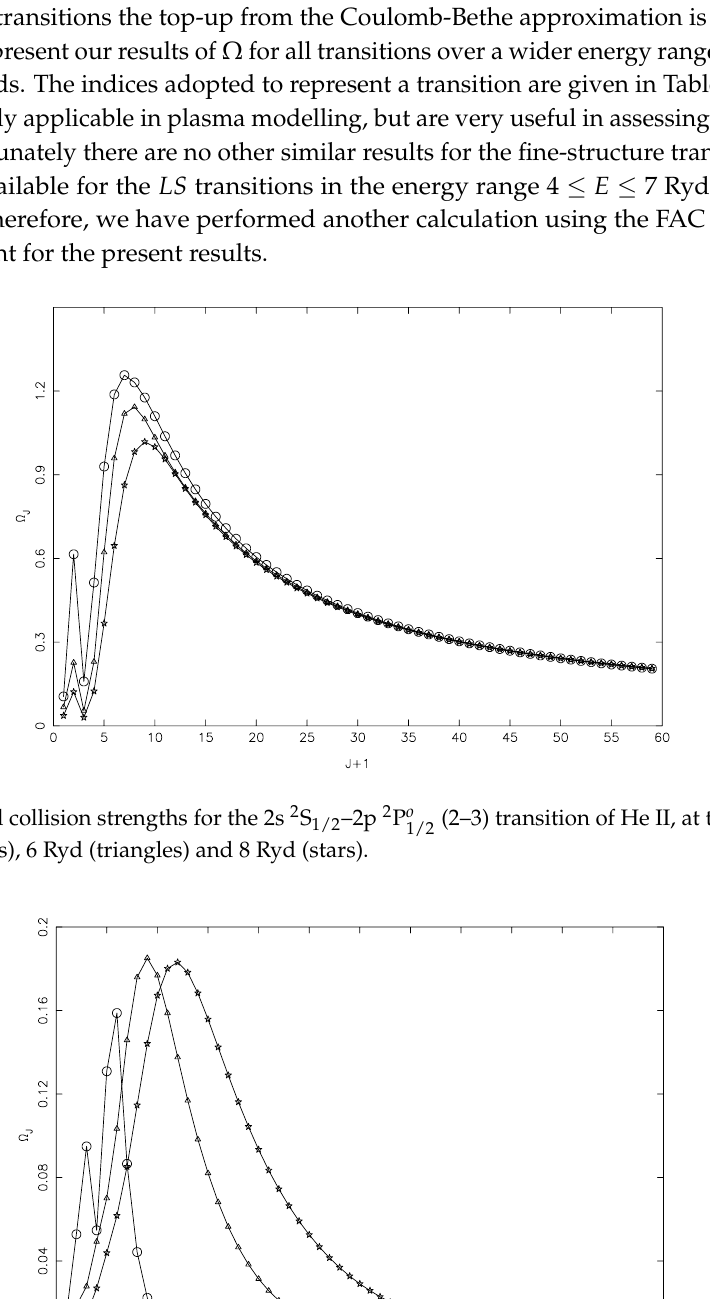
(2–5) transition of He II, at three energies 1/2